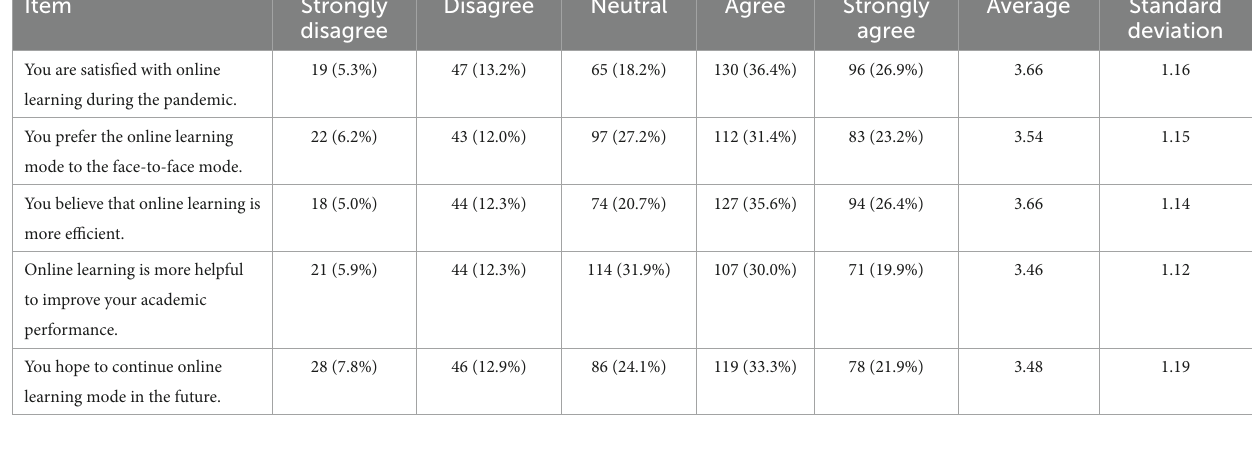
TABLE 5 Whether Chinese higher education students were satisfied with online learning during the COVID-19 pandemic. Item